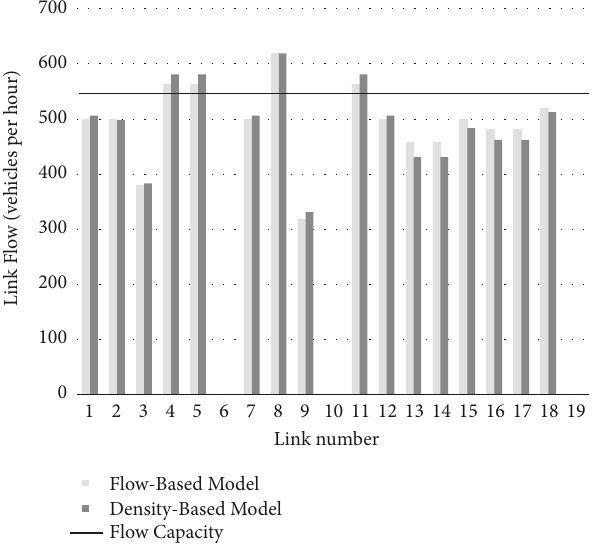
Figure 9: Link Flows, Both Approaches (low congestion).